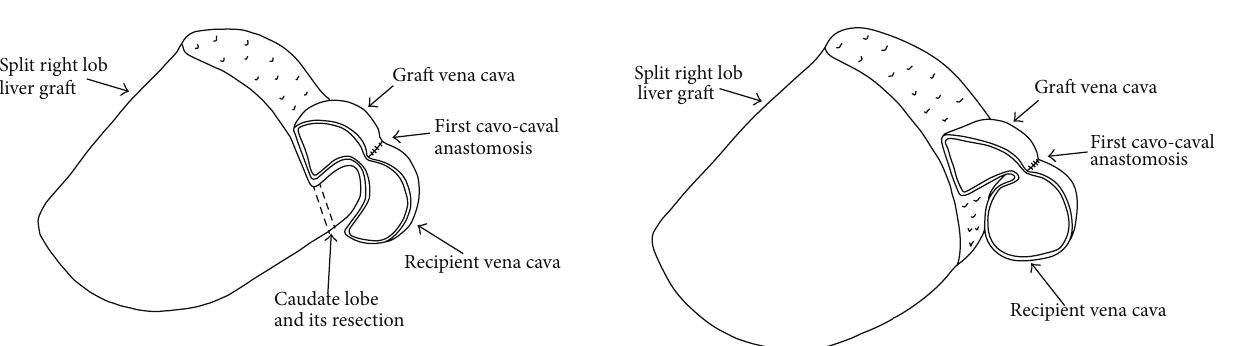
Figure 2: Rotational effect on the cavocaval anastomosis.